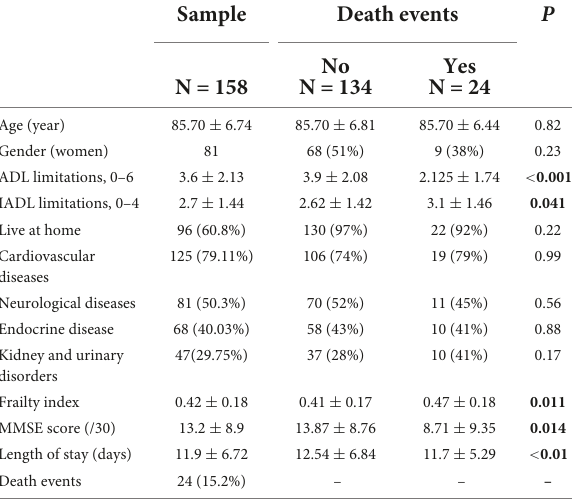
TABLE 2 Characteristics of patients according to death events.